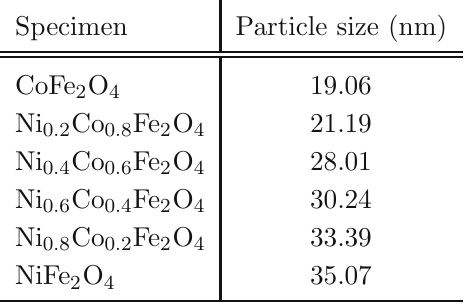
Table 2 Particle sizes of the samples at different